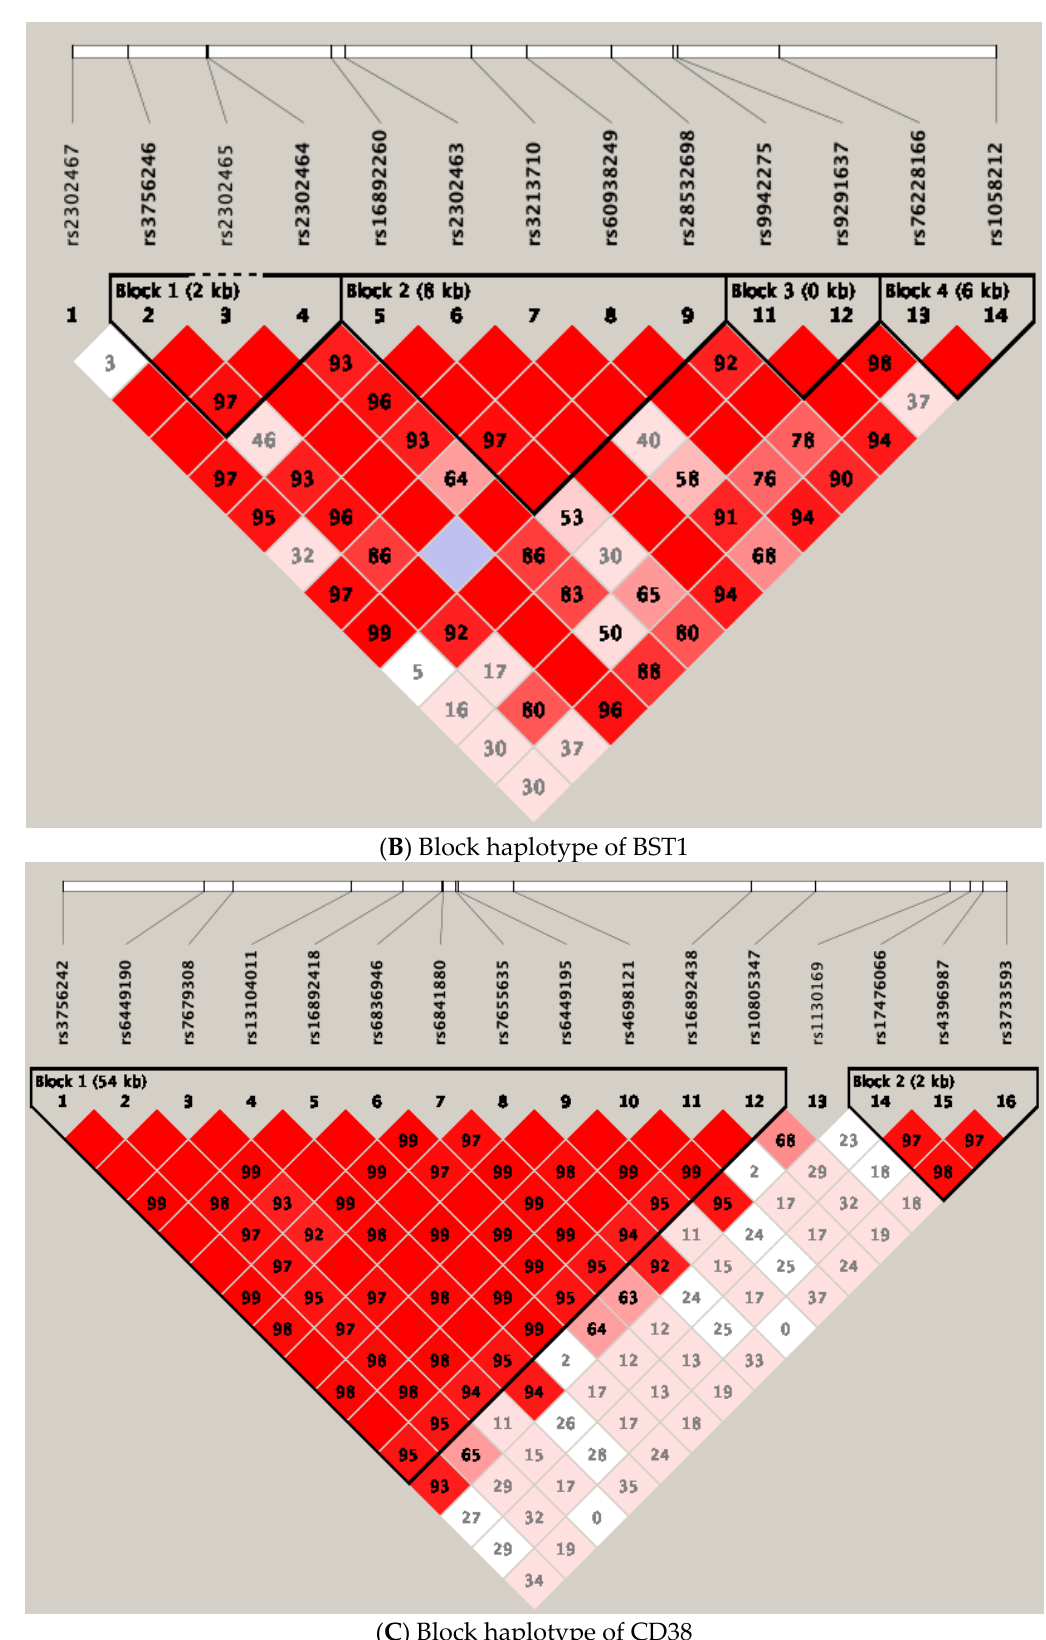
Figure 2. Haplotype Analyses of ACMSD, BST1, and CD38.